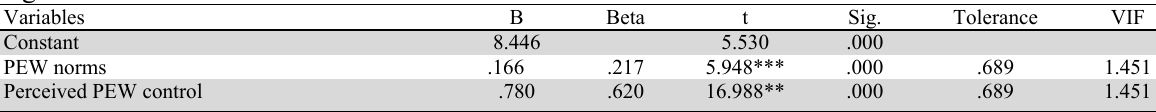
Regression for PEW intention